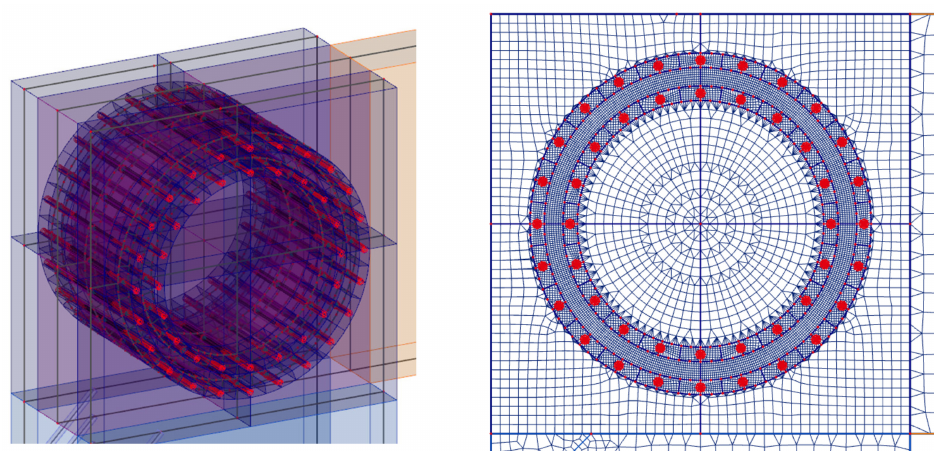
Figure 9. Computational model—detail of the mesh of finite elements of the frame.